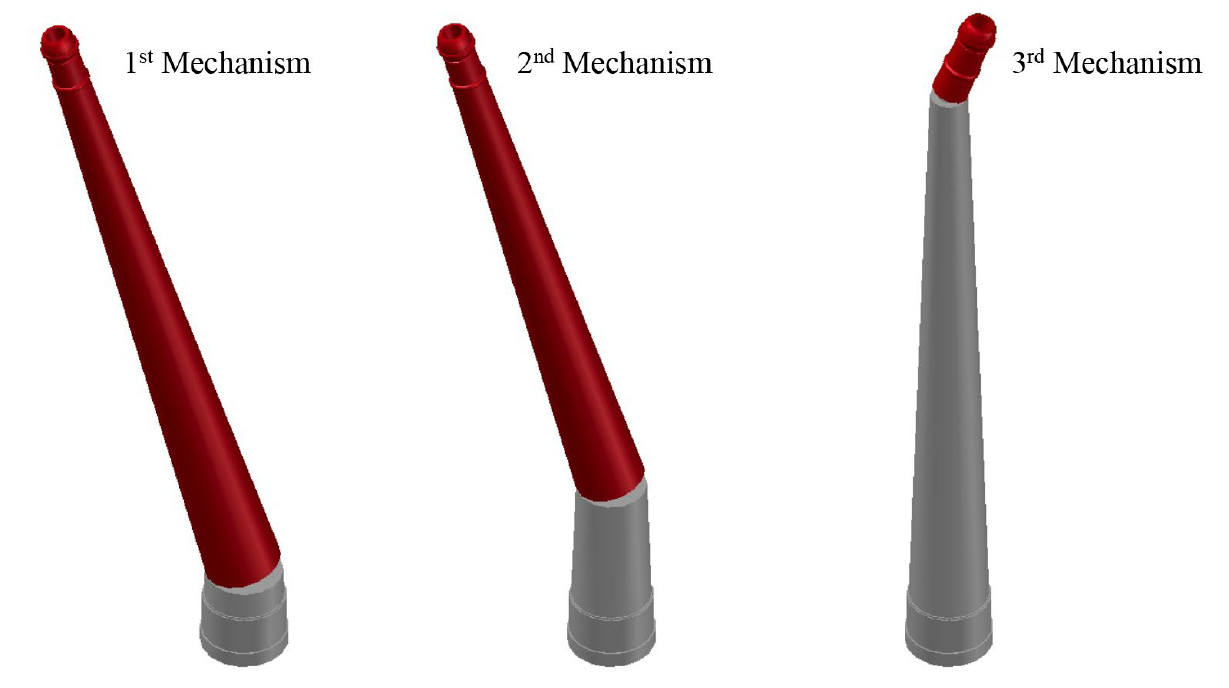
Figure 15. Overturning mechanisms considered for the limit equilibrium